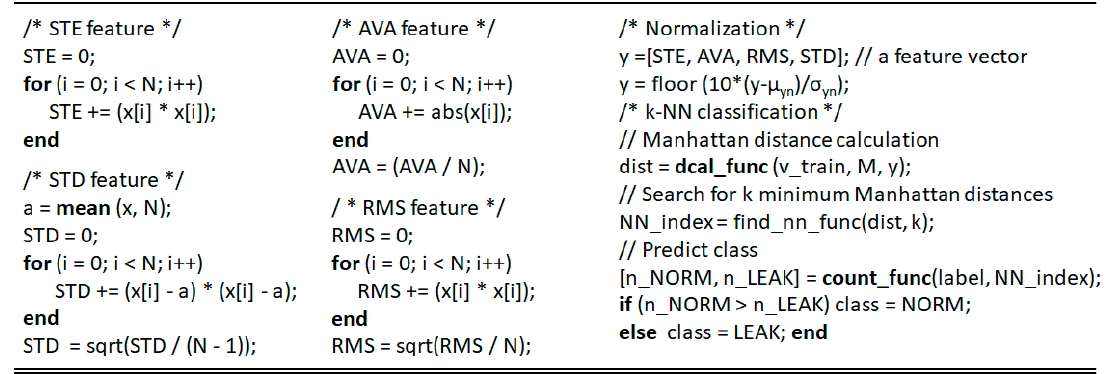
9 of 15 Figure 7. 32F746G-DISCOVERY board (tope view: left side—bottom view: right side). 4.2.2. Real-Time Gas Leak Detection Implementation on the 32F746G-DISCOVERY Board Due to the limitation of the MCU in internal memory and operating speed, we use integer instead of floating-point format for the feature calculation and the k -NN classifi- cation, thus utilizing the memory economically and lightening the computation load. In